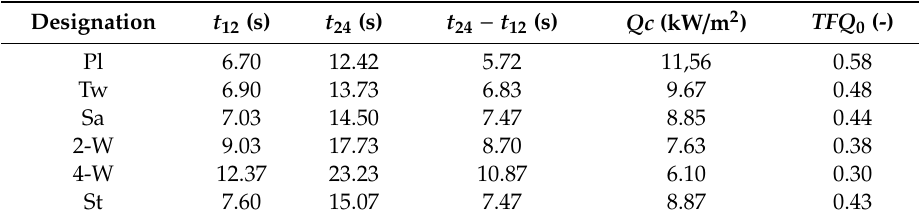
Table 3. Results of fabric resistance to radiant